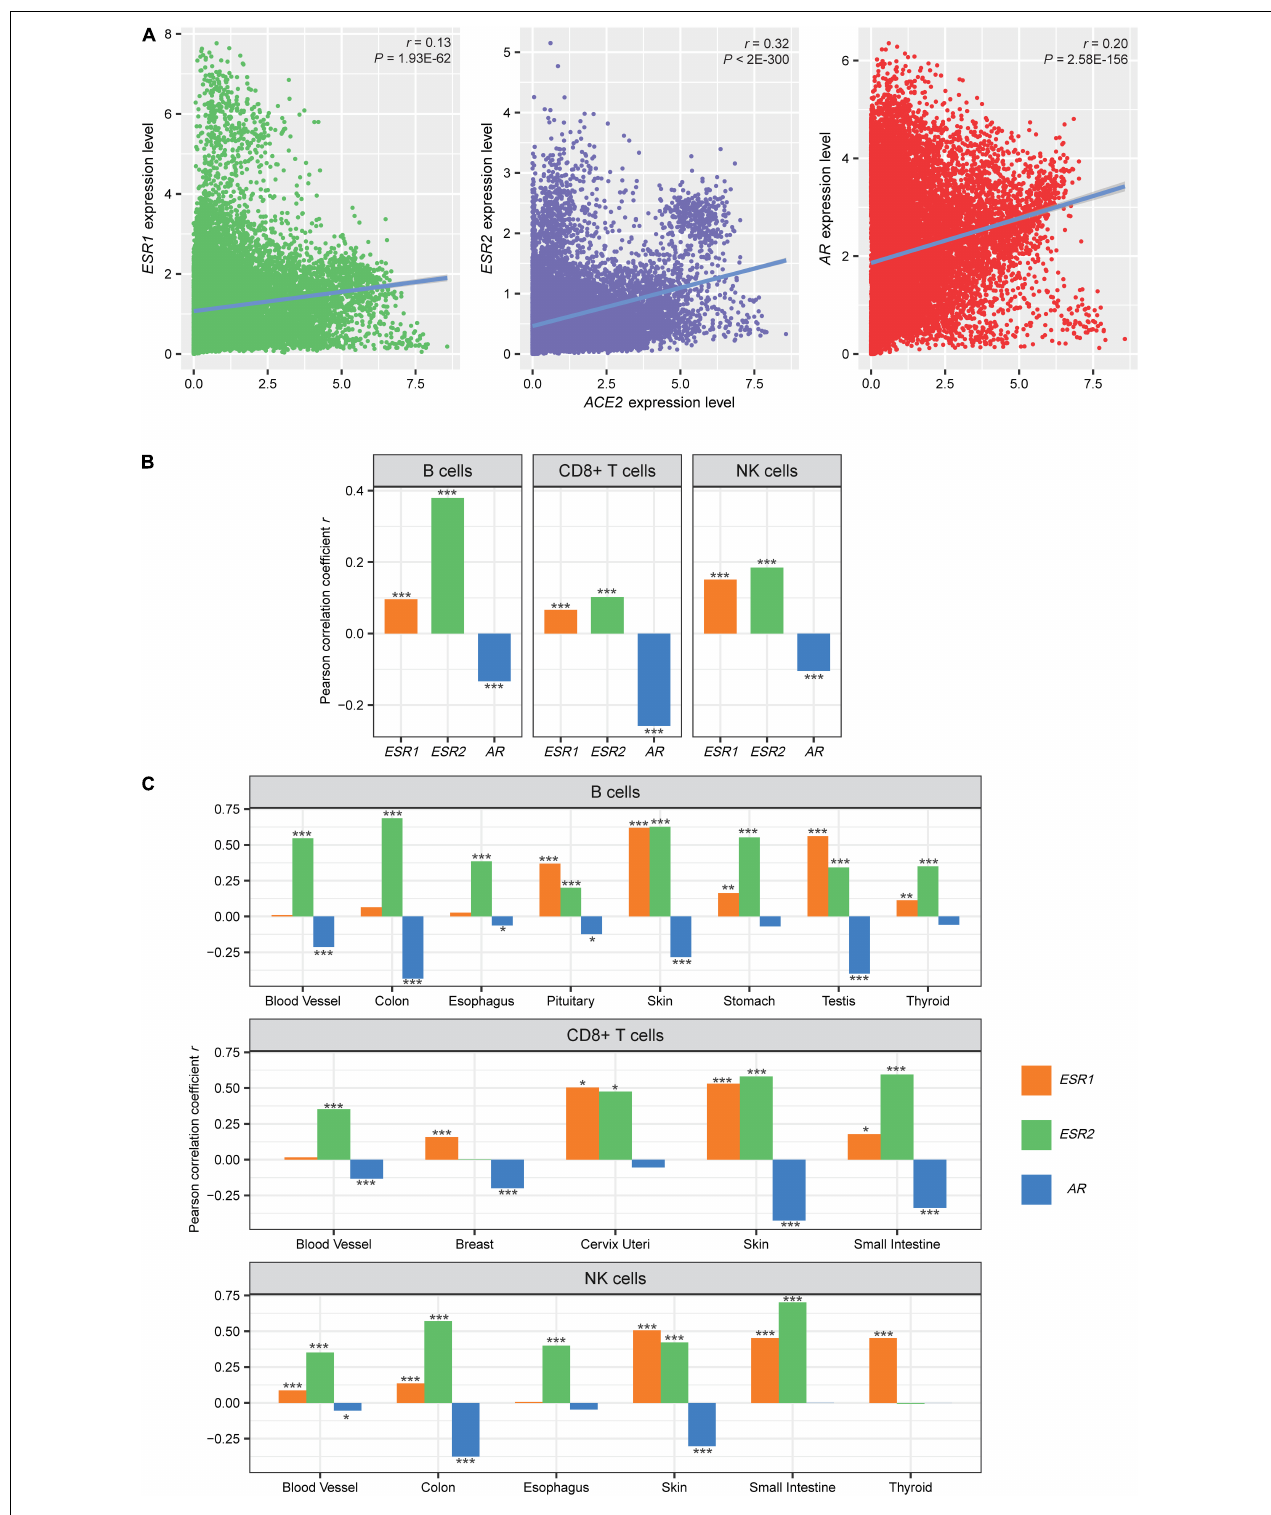
FIGURE 3 | Associations of ACE2 expression and immune signatures with the expression of sex hormone receptor genes. (A) Expression correlations between estrogen receptors (ESR1 and ESR2) and androgen receptor (AR) genes and ACE2 . (B,C) Correlations between the enrichment levels of immune cells and the expression levels of estrogen and androgen receptor genes in pan-tissue and in multiple individual tissues. The correlation coefficient ( r ) and the P -value of Pearson’s correlation test are shown. * P < 0.05, ** P < 0.01, and *** P < 0.001.